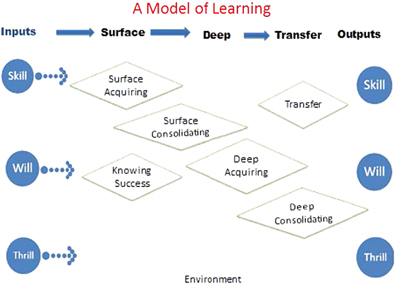
A model of learning.